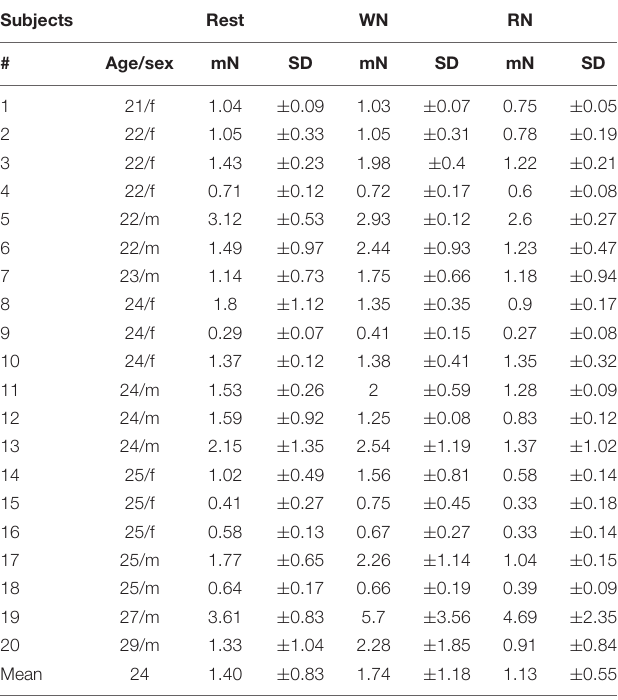
TABLE 1 | Results of somatosensory perception testing with the mechanical detection threshold (MDT). Subjects